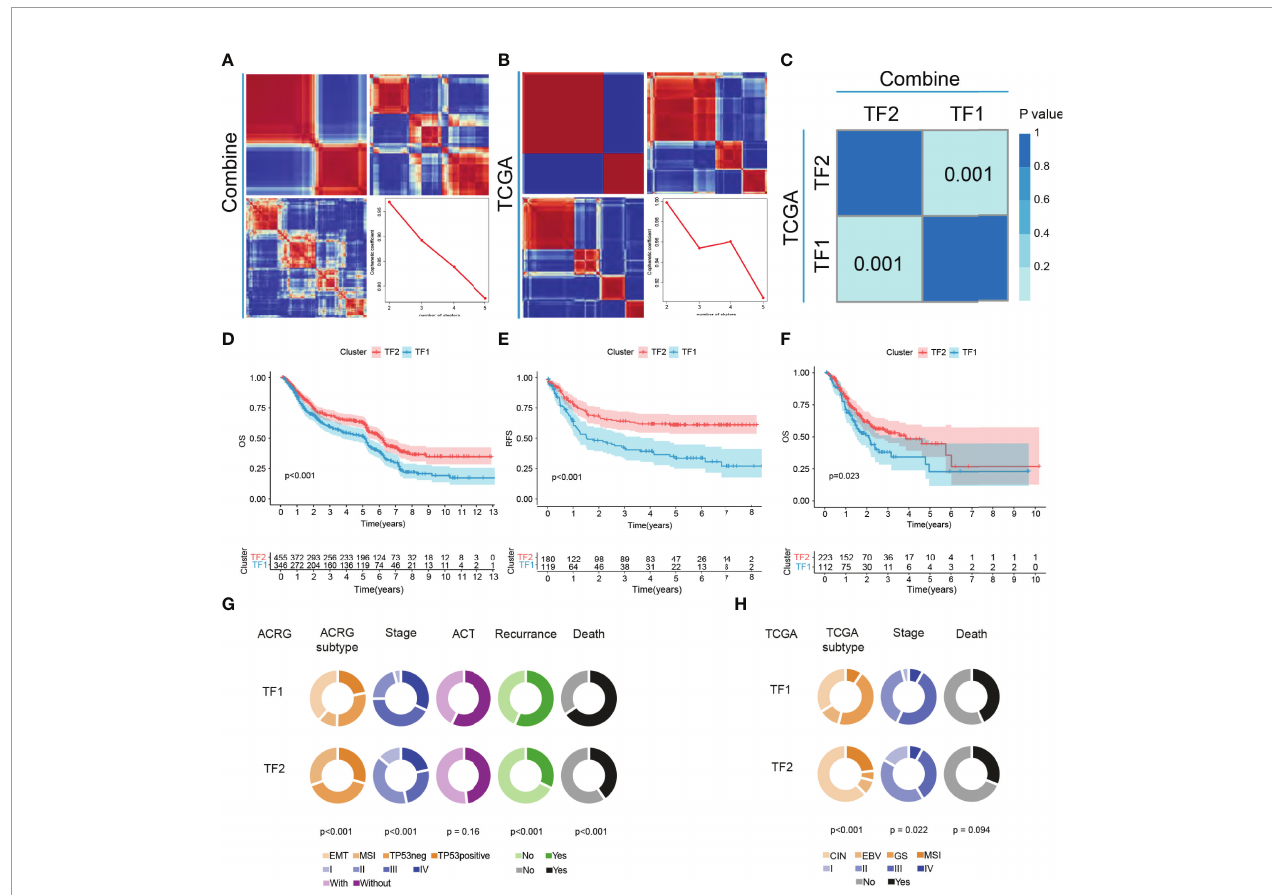
FIGURE 2 | The landscape of clinical features of IRTFs. (A, B) Consensus matrix of the NMF clustering and cophenetic correlation coef fi cient along with the corresponding k values for the combined cohort (A) and the TCGA-STAD cohort (B) . (C) SubMap analysis showed a signi fi cant correlation between the combined cohort and the TCGA-STAD cohort. (D – F) OS and RFS analyses of the two IRTF regulation patterns for the combined cohort (D, E) and the TCGA-STAD cohort (F) . (G, H) The alluvial diagram showing the correlation between IRTF regulation patterns and clinical phenotypes for the ACRG cohort (G) and the TCGA-STAD cohort (H)